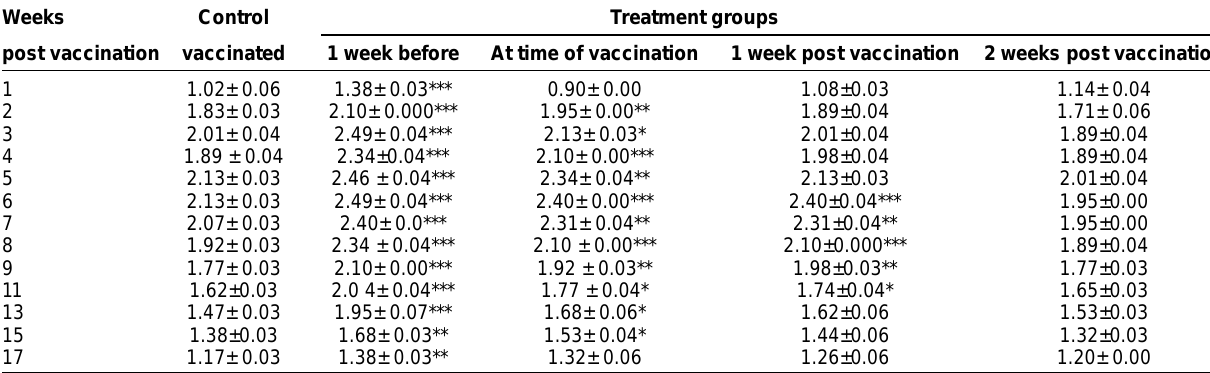
Table-3. Effect of intramuscular injection of Imidocarb dipropionate (3mg/Kg b.wt.) on the Log10of antibody titre using ELISA test in the normal calves vaccinated with FMD vaccine (±S.D.,n=5). Weeks Control Treatment